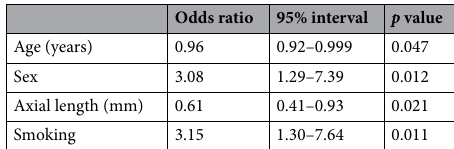
Table 2. Multiple logistic regression analysis to find the factors associated with risk of pachyvessels.